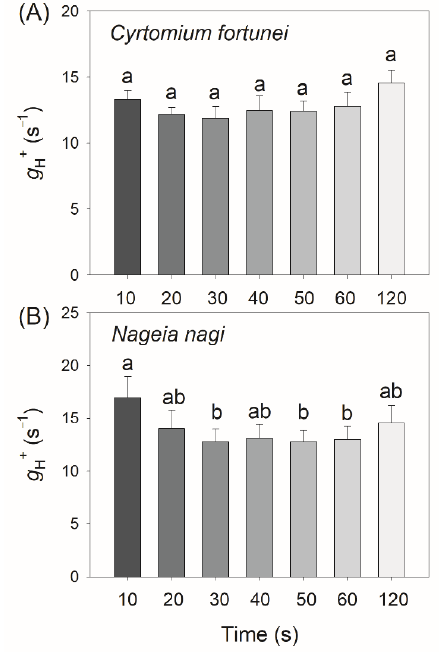
Figure 5. Changes in the activity of chloroplast ATP synthase ( g H+ ) after transition from 59 to 1809 μmol photons m −2 s −1 in leaves of Cyrtomium fortune ( A ) and Nageia nagi ( B ). The data are the means ± SE (n = 5). Different letters indicate significant differences between the different treatments.